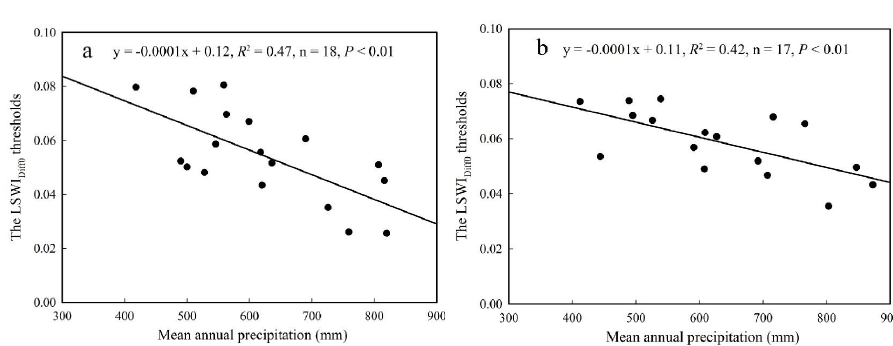
Figure 2. The LSWI difference between non-irrigated (left) or irrigated (right) cropland pixels and their adjacent forests pixels. ( a )The irrigated and non-irrigated cropland pixels were selected from field surveys. Histogram of LSWI values of adjacent forests pixels, irrigated croplands pixels and non-irrigated croplands pixels in northeastern China. ( b )The Latin alphabet ( µ ) stands for the mean value of LSWI. The asterisk indicates the significant difference at the P < 0.01.